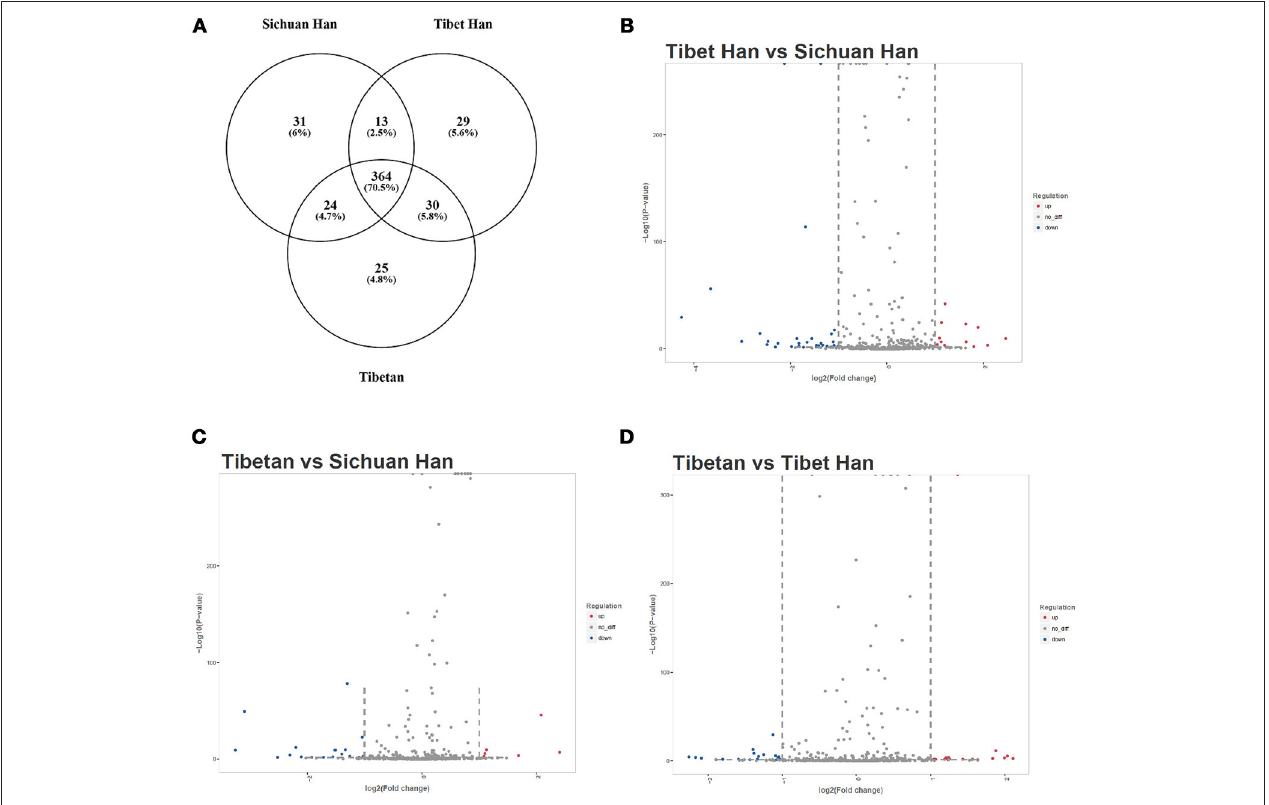
FIGURE 2 | miRNA sequencing analysis of RBC miRNA profiles. miRNAs with more than 1 read in the sequencing data were considered expressed miRNAs. A Venn diagram (A) displays the overlapping miRNAs among the Sichuan Han group, Tibet Han group and Tibetan group. RBC miRNAs were compared between the Tibet Han group and the Sichuan Han group (B) , between the Tibetan group and the Sichuan Han group (C) , and between the Tibetan group and the Tibet Han group (D) . The volcano plot displays the relationship between fold change and significance using a scatter plot view. The red dots in the plot represent significantly upregulated miRNAs, and the blue dots indicate significantly downregulated